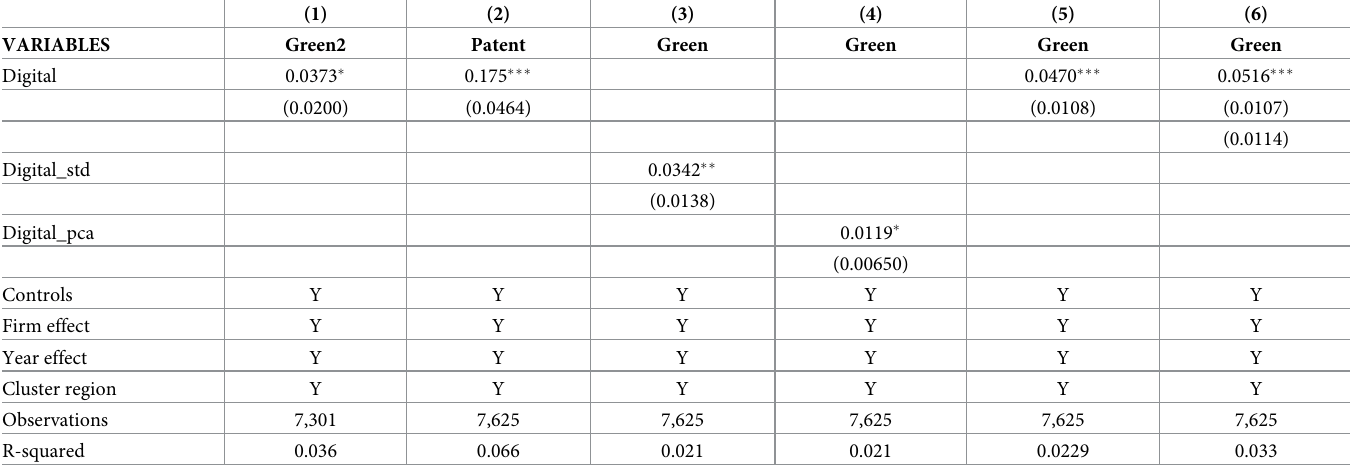
Table 4. Robustness check.